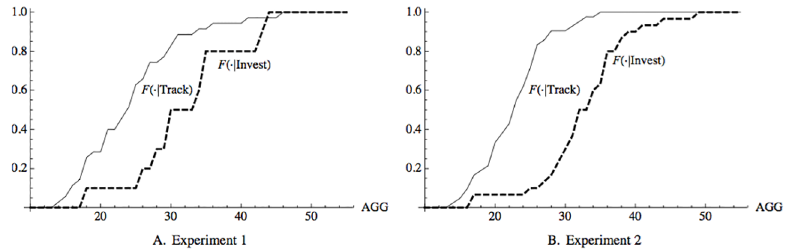
Fig 1. The cumulative distribution of aggression scores conditioned on tracking and investing in Experiments 1 and 2. In each of the panels of the figure, the horizontal axes labeled “AGG” represents subject scores on the aggression instrument. In both panels, the empirical cumulative distributions conditioned on investing (dashed line), F ( (cid:1) |Invest), and tracking (solid line), F ( (cid:1) |Track), are depicted.